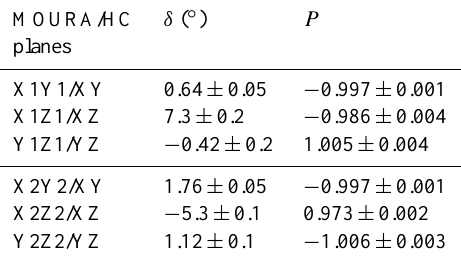
Table 7. Parameters δ and P of Eq.